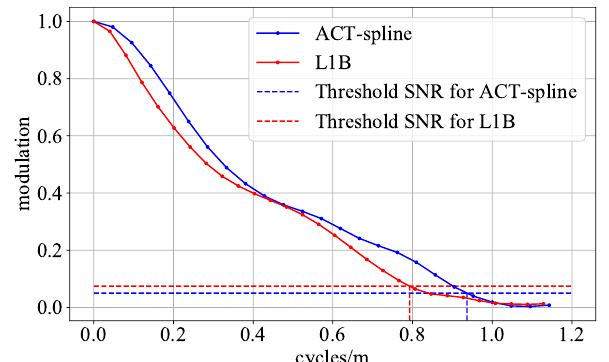
Figure 9. MTF estimated using a SkySat acquisition of a real calibration target located in Baotou, China. The proposed method ACT-spline produces an image with sharper edges than the L1B product provided by Planet. Using this plot a ground resolution per pixel can be estimated from the images: L1B is 63 cm/pixel while ACT-spline is 53 cm/pixel.